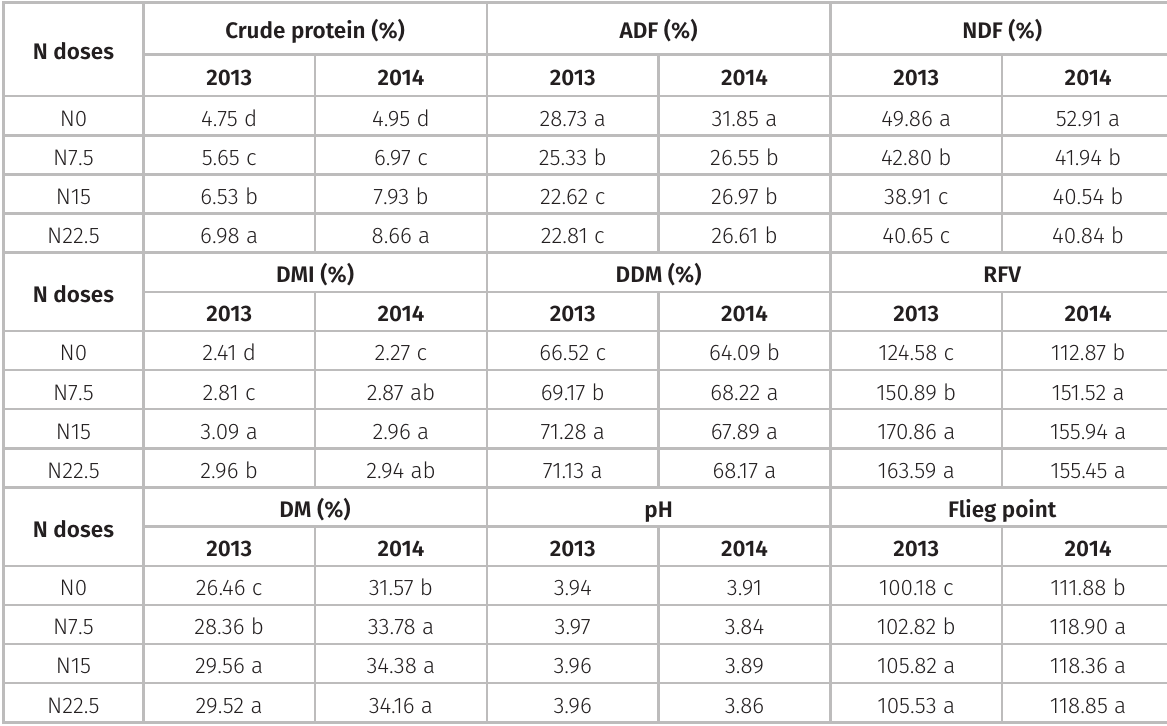
Table III. Effects of different nitrogen doses on silage quality. Crude protein N doses